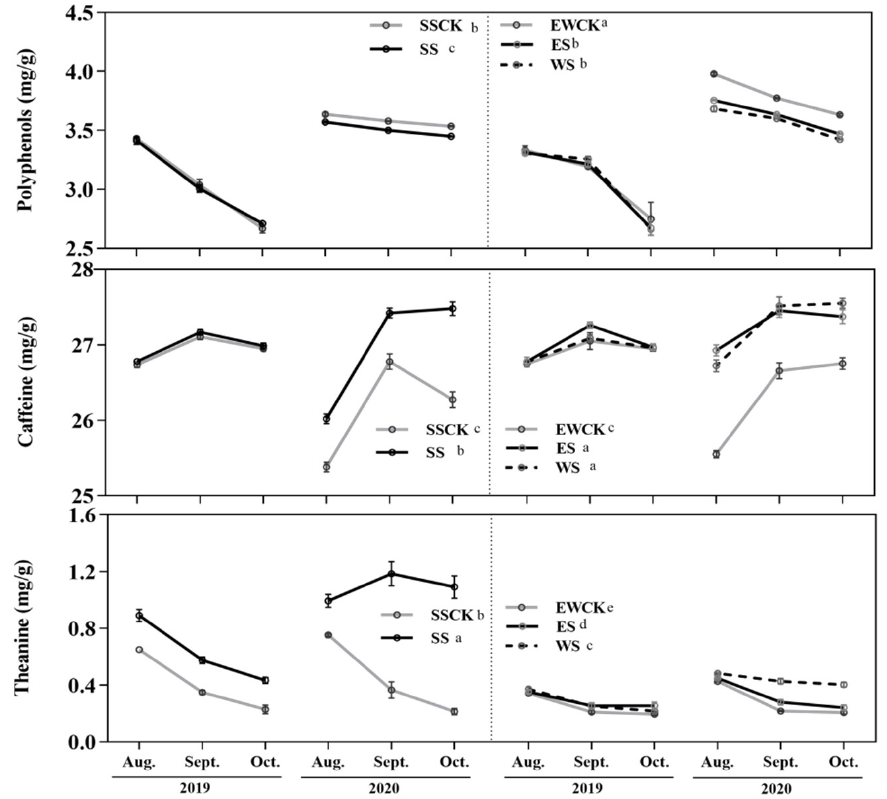
Figure 3. Foliar contents of the functional components of tea plants under intercropped maize ecological shading in a tea plantation.